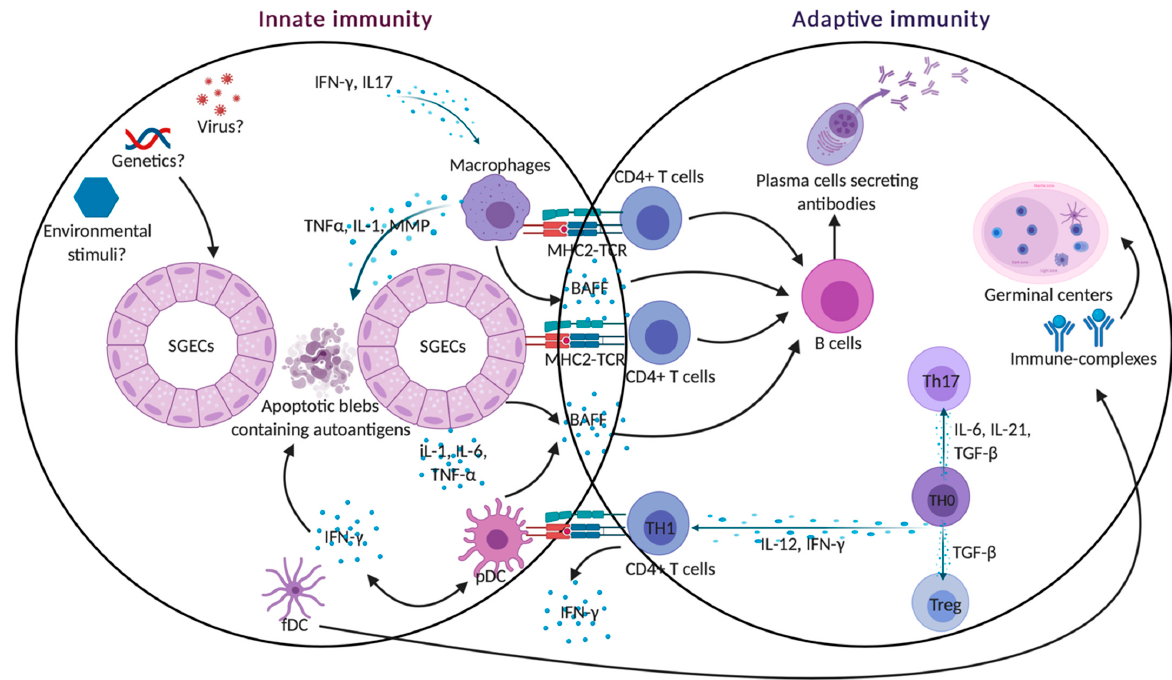
Figure 3. Innate and adaptive crosstalk. Activated SGECs secrete BAFF that promotes the activation and maturation of B cells into long-lasting memory B cells and plasma B cells producing auto-antibodies. SGECs also produce chemokines IL-1, IL-6, IL18, and TNF α that attract immune cells and contribute to the formation of germinal centers. Activated SGECs have the ability to act as non-professional antigen-presenting cells by expressing MHC-I (HLA-ABC) and MHC-II (HLA-DR) adhesion molecules such as ICAM1, allowing them to activate T cells. TLR activation also contributes to SGEC apoptosis, releasing autoantigens that drive autoimmunity in pSS. Activated macrophages can act as antigenic peptide presenting cells through their MHC-II and interact with antigen-specific CD4+ T cells. pDCs lead to the production of type I IFN that acts through autocrine and paracrine circuits feeding a continuous reinforcing inflammatory loop. It also induces BAFF production, contributing to the activation of B cells into plasma cells. DCs also play an essential part in the structure of ectopic germinal centers and retain on their surface immune-complexes, formed by